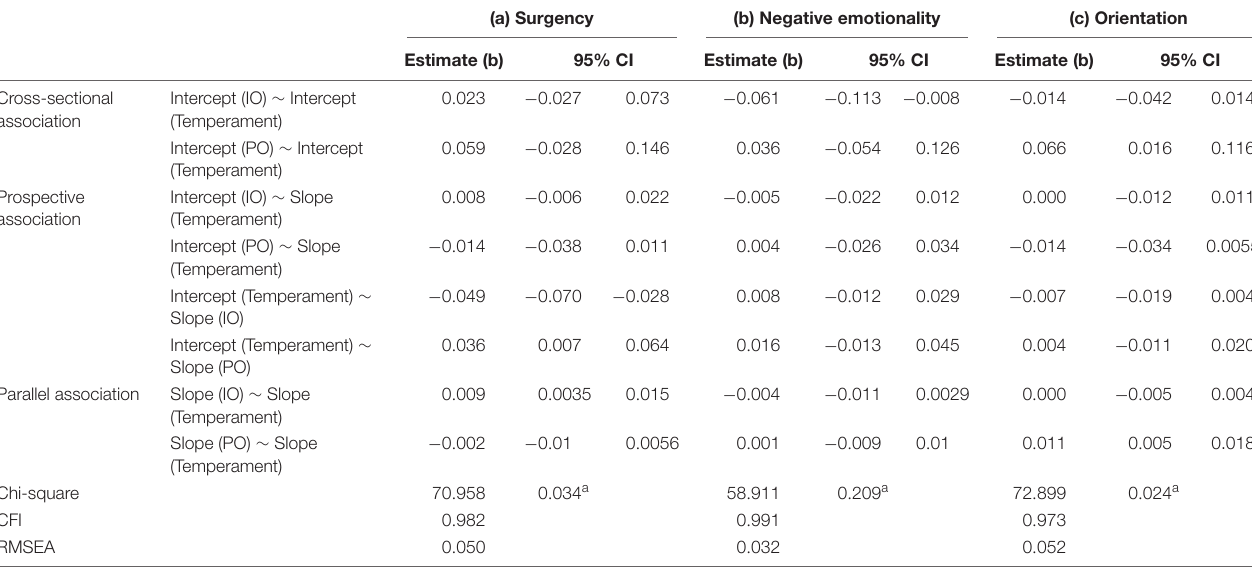
TABLE 3 | Parameter estimates from the parallel latent growth